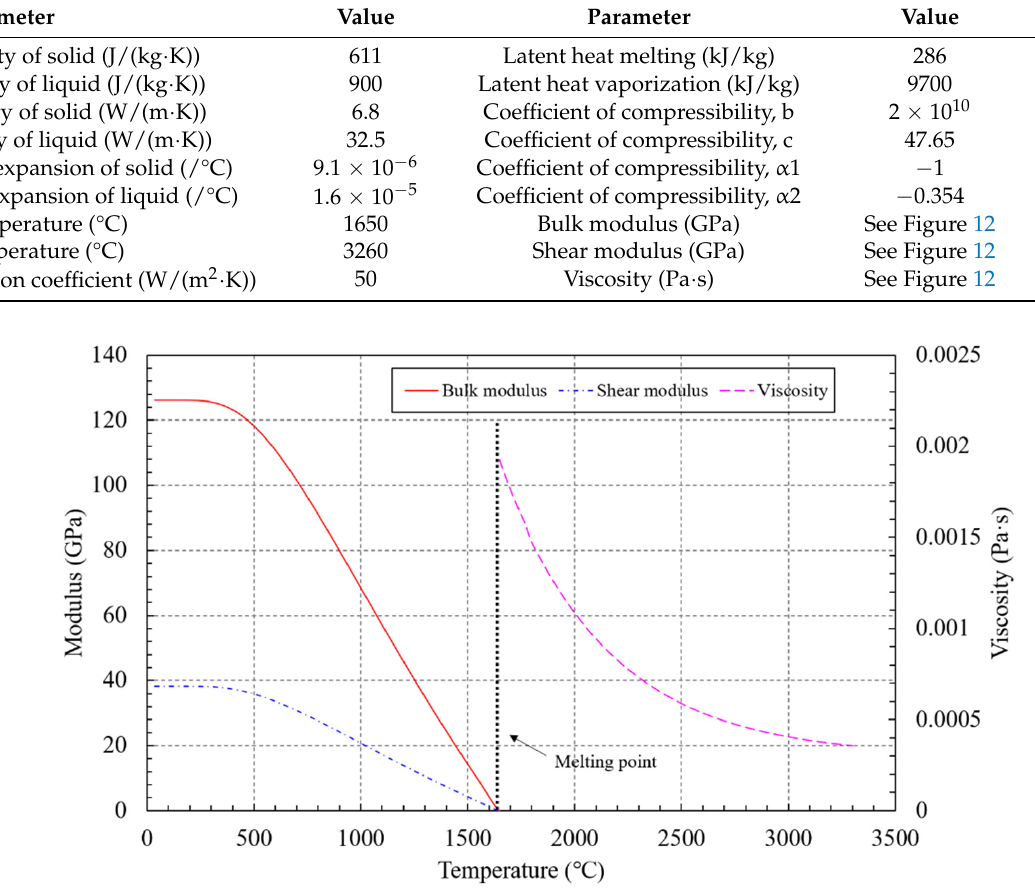
Figure 12. The modulus and viscosity of Ti–6Al–4V.